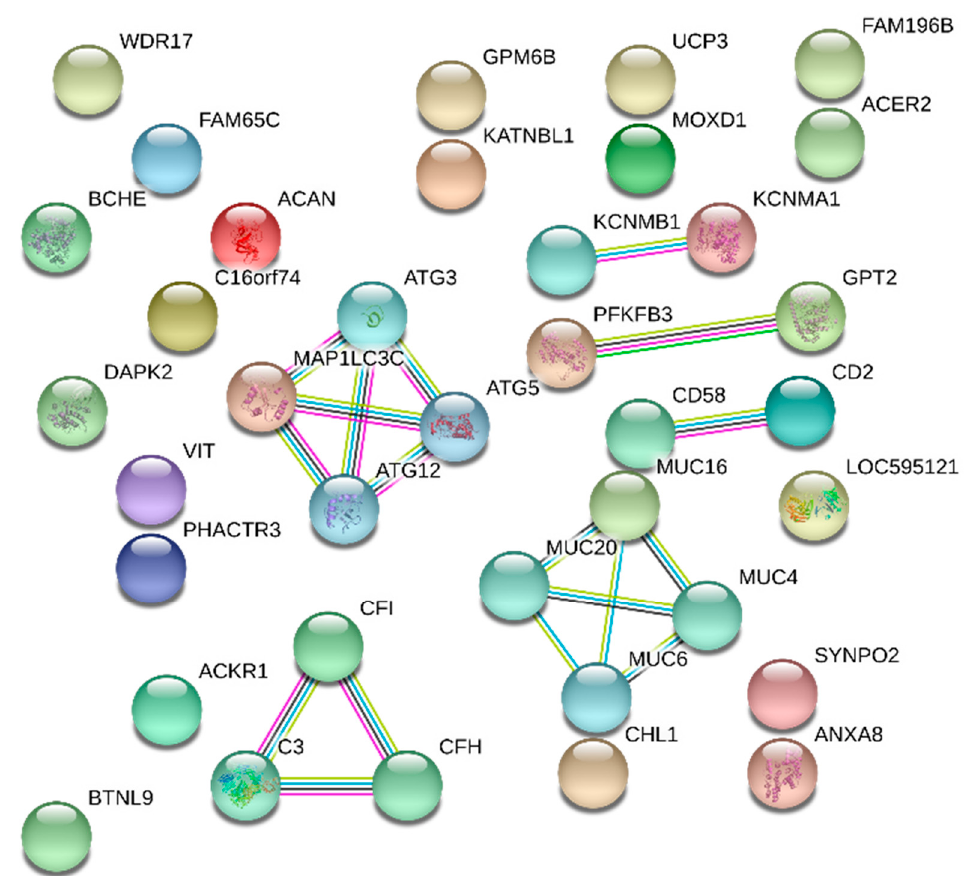
Figure 5. Gene interaction network with differentially expressed genes common to both scrotal and umbilical hernias. Legend: gene network built with 27 of the 35 differentially expressed genes common to both types of hernia obtained with the STRING database using information from Sus scrofa proteins.